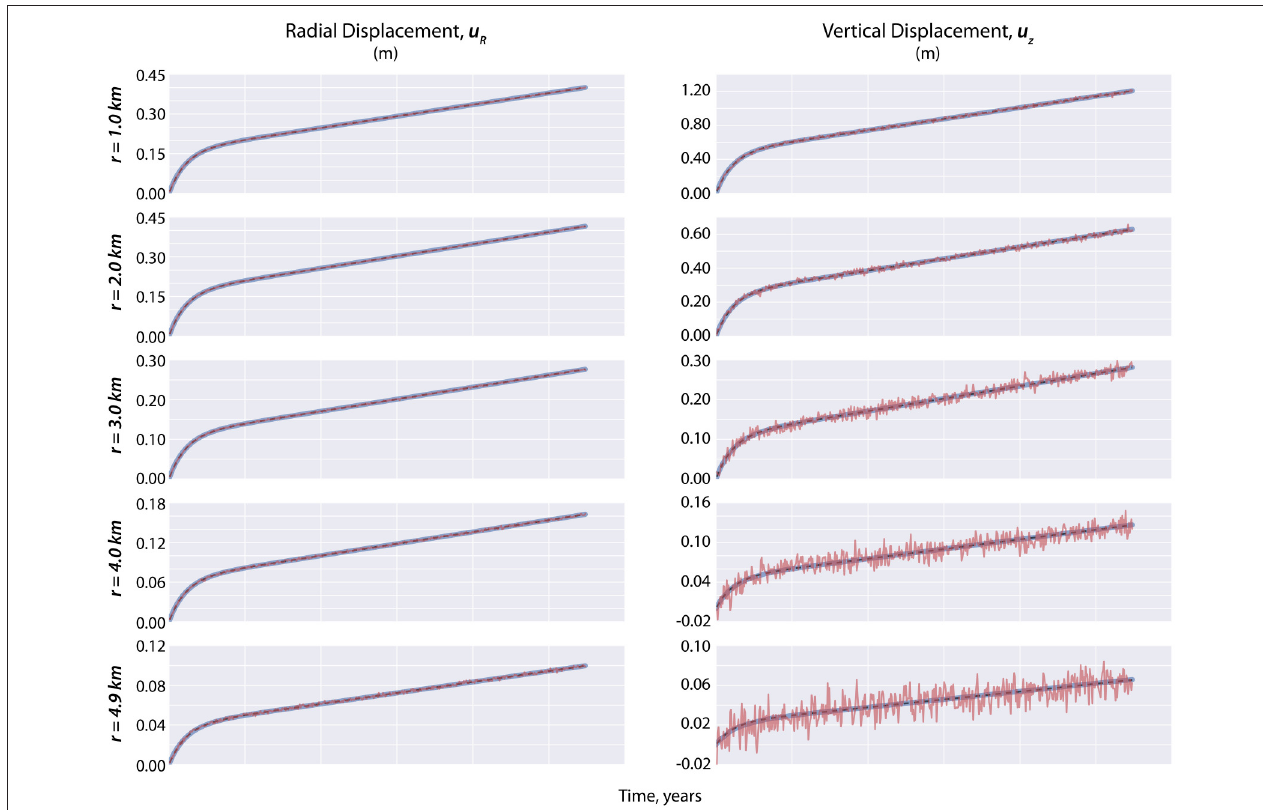
FIGURE 9 | Ten of the 80 EnKF-estimated displacements after performing assimilation via state-parameter estimation (i.e., blue solid line) given that the prior distributions of the parameters are biased ( Figure 7C ). The synthetic observations used as D during assimilation are the noisy red lines that are more evident in the vertical component at far-field distances. The black broken lines correspond to the true values of the